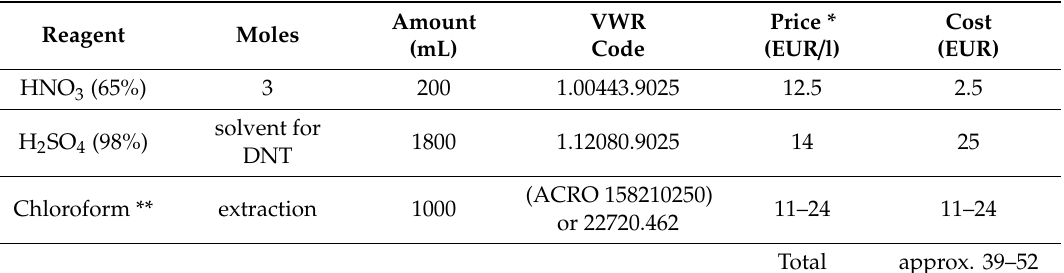
Table 4. Approximate cost of the reagents needed for the conversion of 1 mole 2,4-DNT to TNT using the described flow chemistry